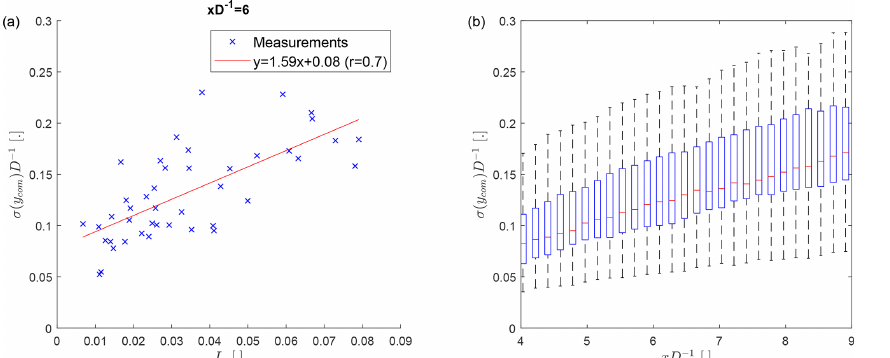
Figure 8. The normalized wake meandering strength ( σ ( y com ) D − 1 ) as a function of the lateral turbulence intensity ( I v ) at xD − 1 = 6 (a) . The legend shows the equation of a linear fit to the measurements (red line) and their correlation coefficient. The distribution of the observed wake meandering strength as a function of downstream distance (b) . The whiskers show the range of the data, the top and bottom of the blue box indicate the 25th and 75th percentiles, and the red centre marker is the median.